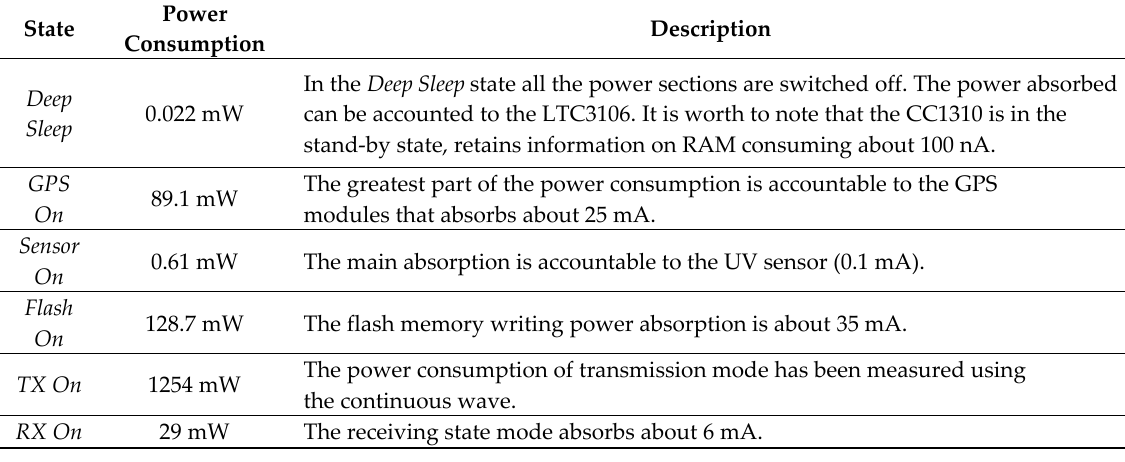
Table 1. Average power consumptions.